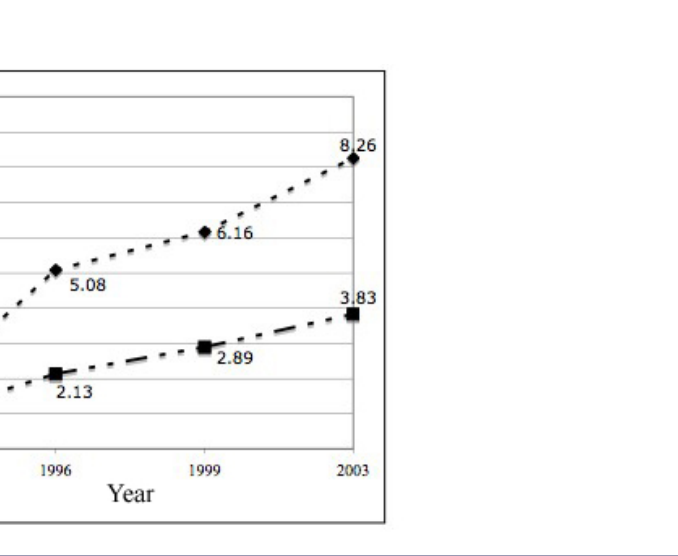
Fig. 2. Land-cover transition caused by deforestation for